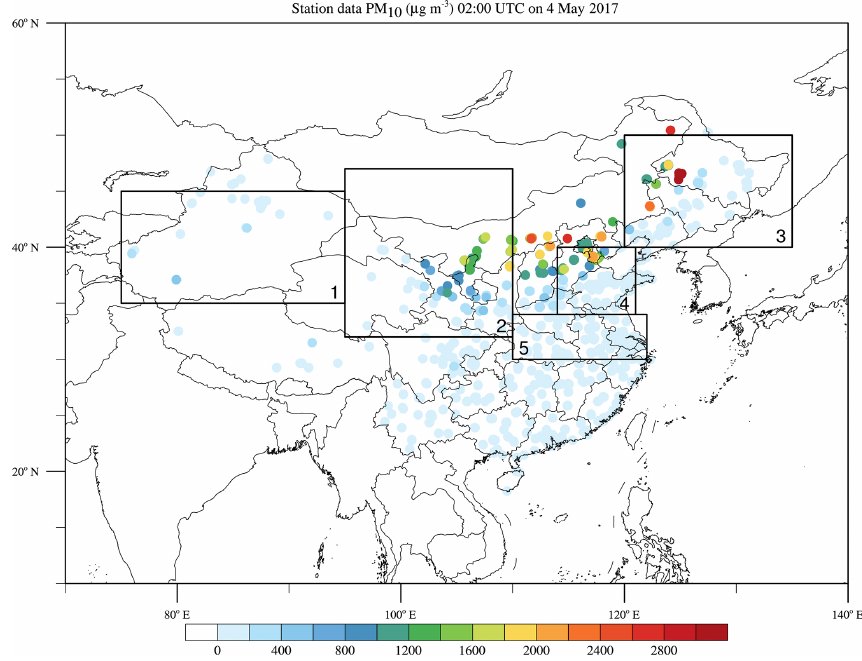
Figure 7. Five subregions and observed PM 10 concentrations. Key: “1” represents the Taklimakan Desert (TD), “2” represents the Gobi Desert (GD), “3” represents the Northeast Plain (NEP), “4” represents the North China Plain (NCP), and “5” represents the middle and lower reaches of Yangtze River plain (YR). The colored dots represent observed PM 10 concentrations over observational sites at 02:00UTC